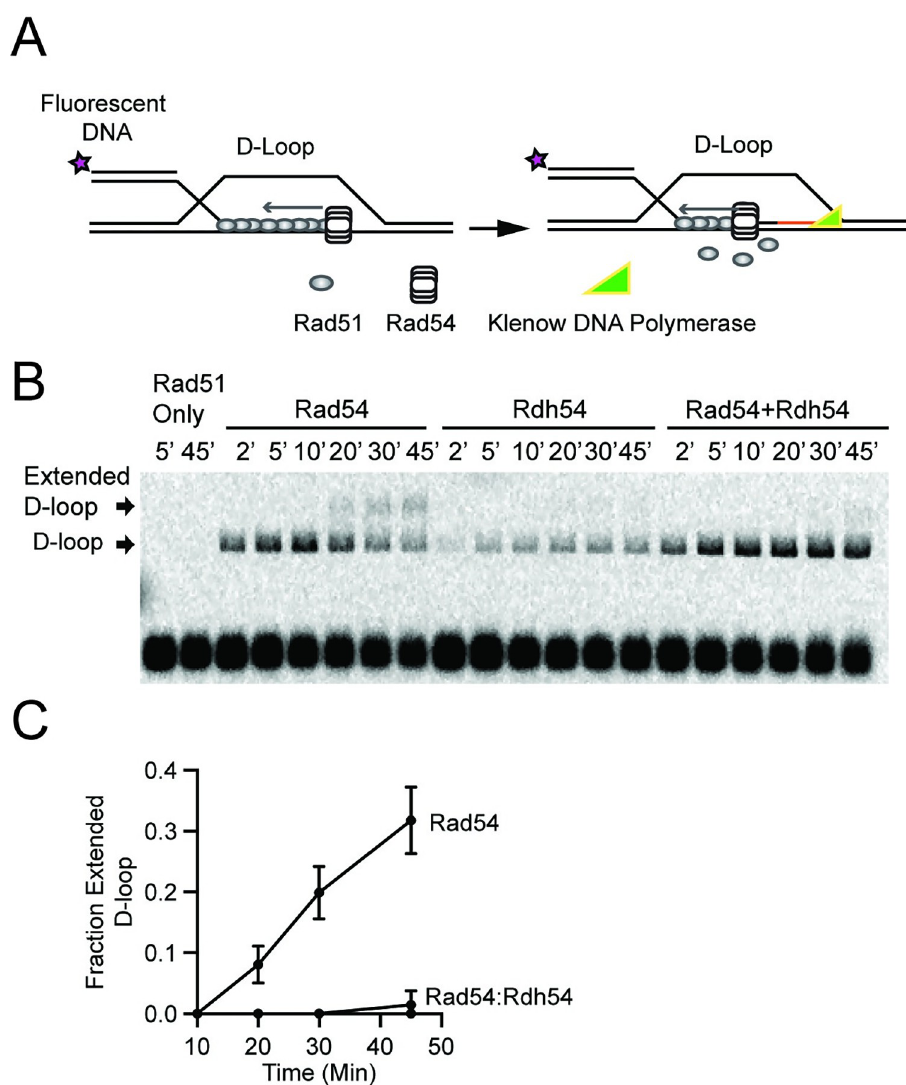
Fig 4. Rdh54 prevents Rad54 from creating accessible 3’ end at D-loop intermediates. (A). Cartoon diagram illustrating the experiment to monitor the 3’ end accessibility by using Klenow (exo-) to extend the nascent D-loop. The recipient DNA used in this experiment was 21 nt of homologous ssDNA and 36 bp of duplexed non-homologous DNA (B). Representative gel illustrating D-loop extension for Rad51 alone, Rad51+Rad54 (30 nM), Rad51+Rdh54 (30 nM), and Rad51+Rad54 (30 nM) +Rdh54 (30 nM). (C). Quantification of extended D-loop fraction. The error bars represent the standard deviation for three independent